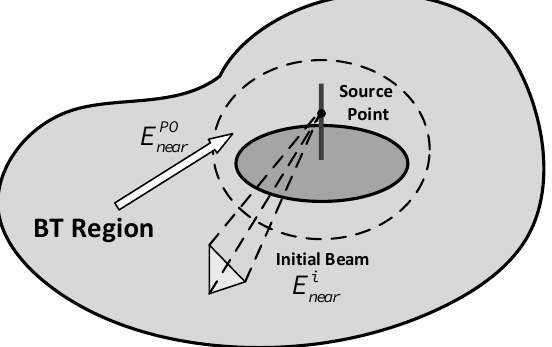
Figure 6. The couple intersection between the MLFMA region and the BT